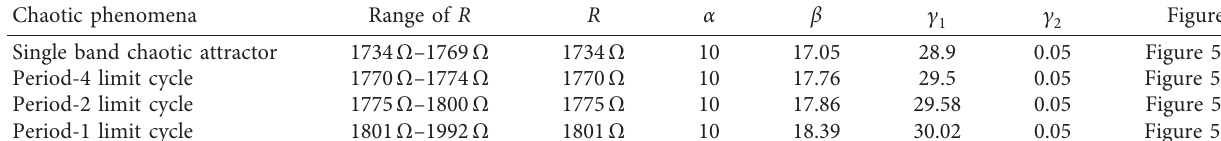
Table 1: Chaotic phenomena of the modified Chua’s chaotic system by increasing resistance R values. Chaotic phenomena Range of R Single band chaotic attractor 1734 Ω –1769 Ω Period-1 limit cycle